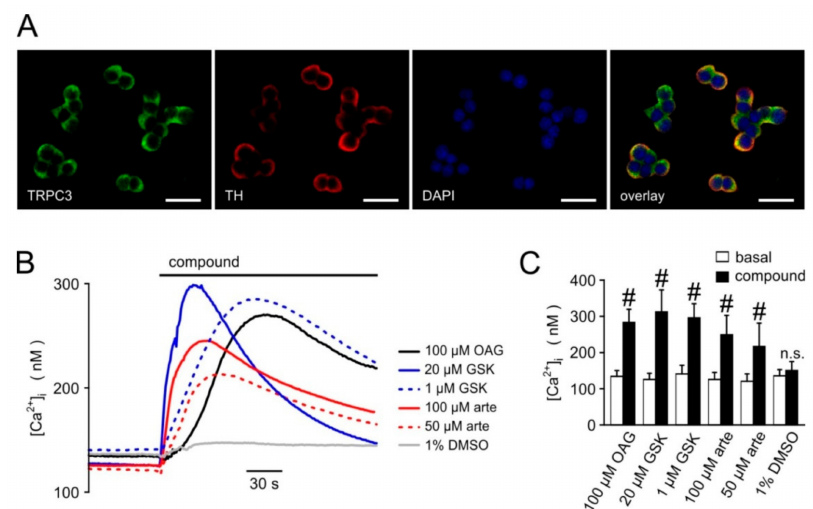
Figure 7. Expression of TRPC3 and functional responses to TRPC activators in PC12 rat pheochromocytoma cells. ( A ) Immunofluorescence analysis of TRPC3 (green channel) and tyrosine hydroxylase (TH; red channel) expression in PC12 cells. Nuclei were counterstained with DAPI (blue channel). Bars: 20 µ m scale. Time course of the [Ca 2 + ] i ( B ) and averaged basal and peak [Ca 2 + ] i values ( C ) were recorded by microfluorometric analysis in fura-2-loaded PC12 cells grown on glass coverslips. The cells were challenged with the indicated concentrations of OAG, GSK-1702934A (GSK), and artemisinin (arte) or the final concentration of its solvent (DMSO). Data represent averages ( B ) or means and S.D. ( C ) of 6–12 imaging experiments for each compound. Significant increases compared to the respective basal values are indicated (#: p < 0.05; Student´s t -test for paired data).